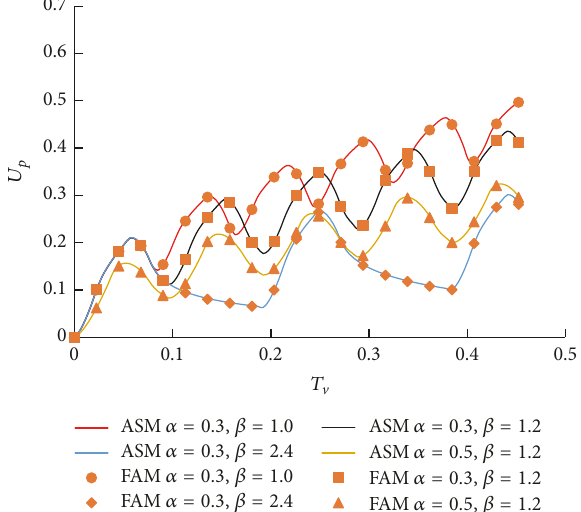
Figure 8: 𝑈 𝑝 versus 𝑇 V curves for trapezoidal cyclic loading.